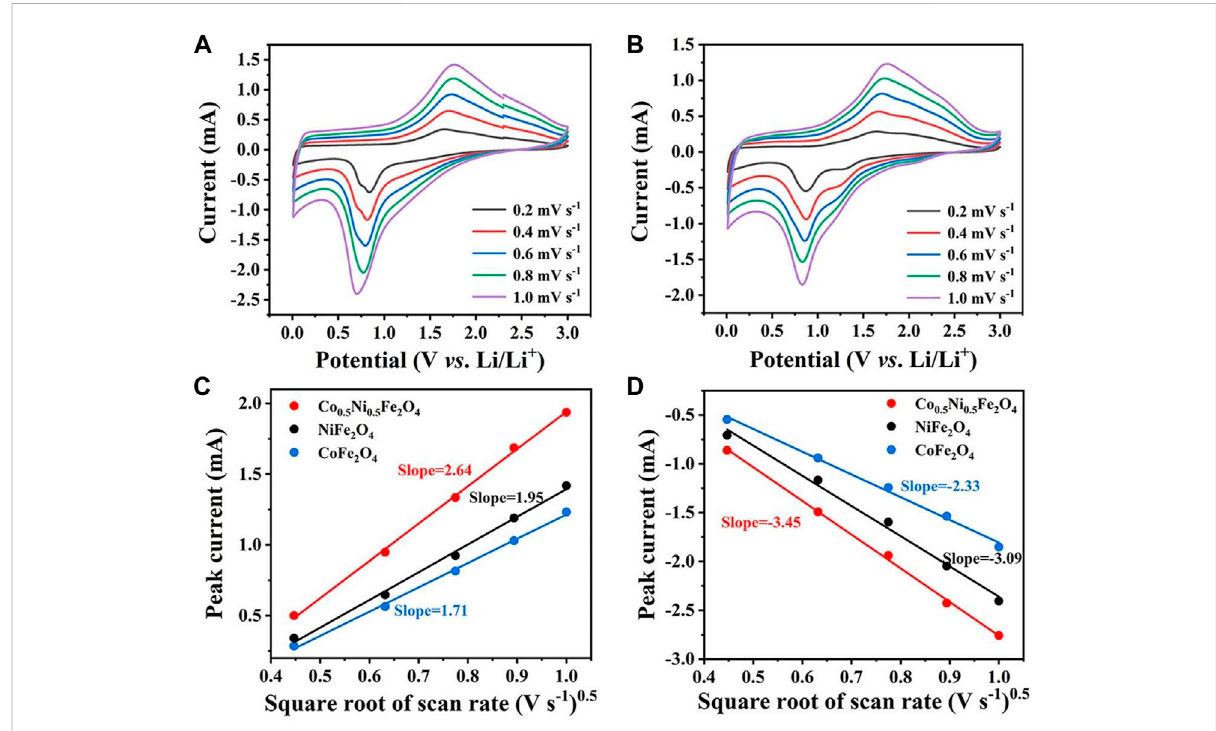
FIGURE 6 CV curves of (A) NiFe 2 O 4 and (B) CoFe 2 O 4 at various scan rates. Linear relationship between CV peak current of (C) anodic and (D) cathodic peaks and the square root of scan rate for NiFe 2 O 4 and CoFe 2 O 4 , and Co 0.5 Ni 0.5 Fe 2 O 4